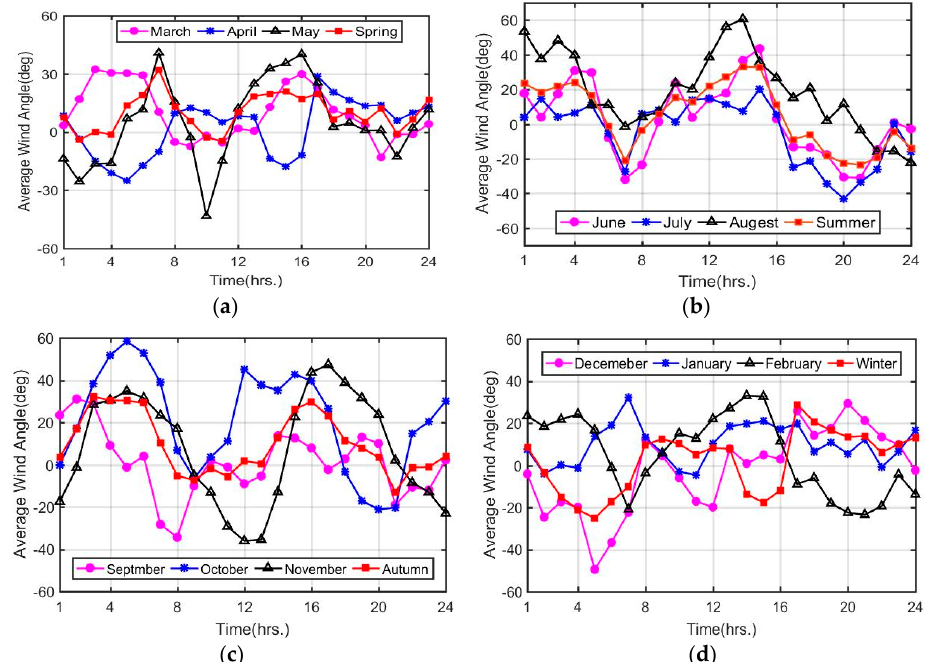
Figure 6. Wind angle variation during each day: ( a ) spring and its three months; ( b ) summer and its three month; ( c ) autumn and its three month; ( d ) winter and its three months.